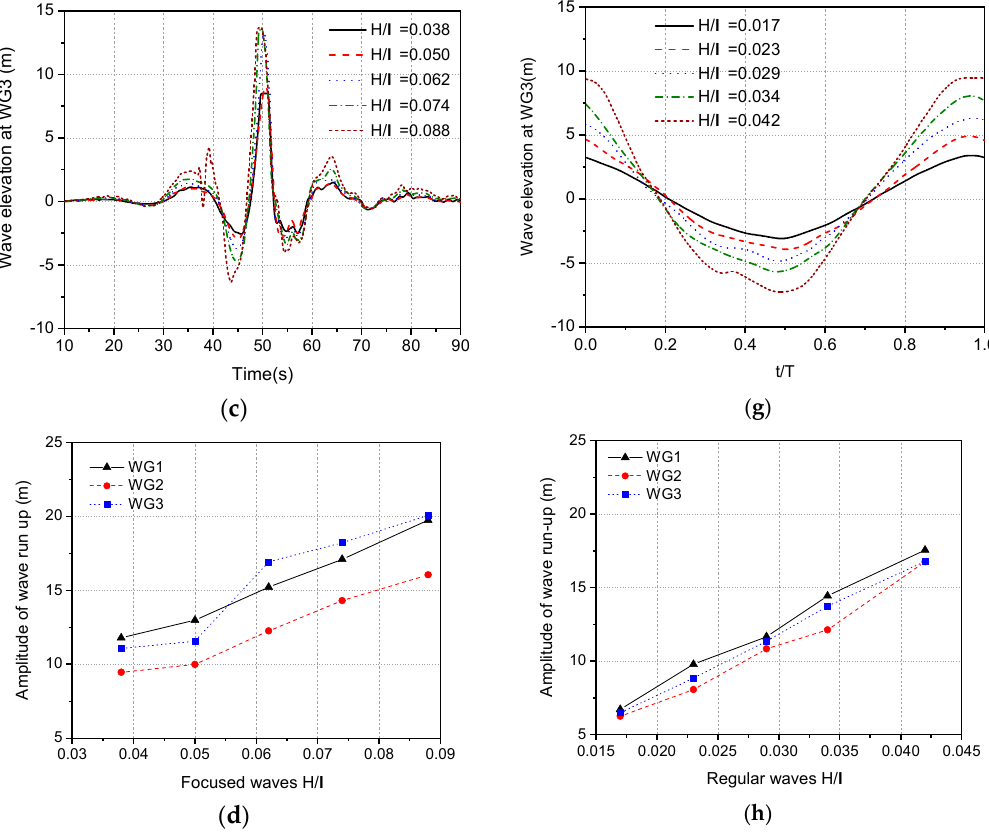
Figure 15. Wave elevation around a semi-submersible platform: ( a ) WG1 wave elevation under focused wave (Cases 1 to Case 5) ( b ) WG2 wave elevation under focused wave (Case 1 to Case 5) ( c ) WG3 wave elevation under focused wave (Cases 1 to Case 5) ( d ) Amplitude of wave run up under focused wave (Cases 1 to Case 5) ( e ) WG1 wave elevation under regular wave (Cases 6 to Case 10) ( f ) WG2 wave elevation under regular wave (Case 6 to Case 10) ( g ) WG3 wave elevation under regular wave (Case 6 to Case 10) ( h ) Amplitude of wave run up under regular wave (Cases 6 to Case 10).